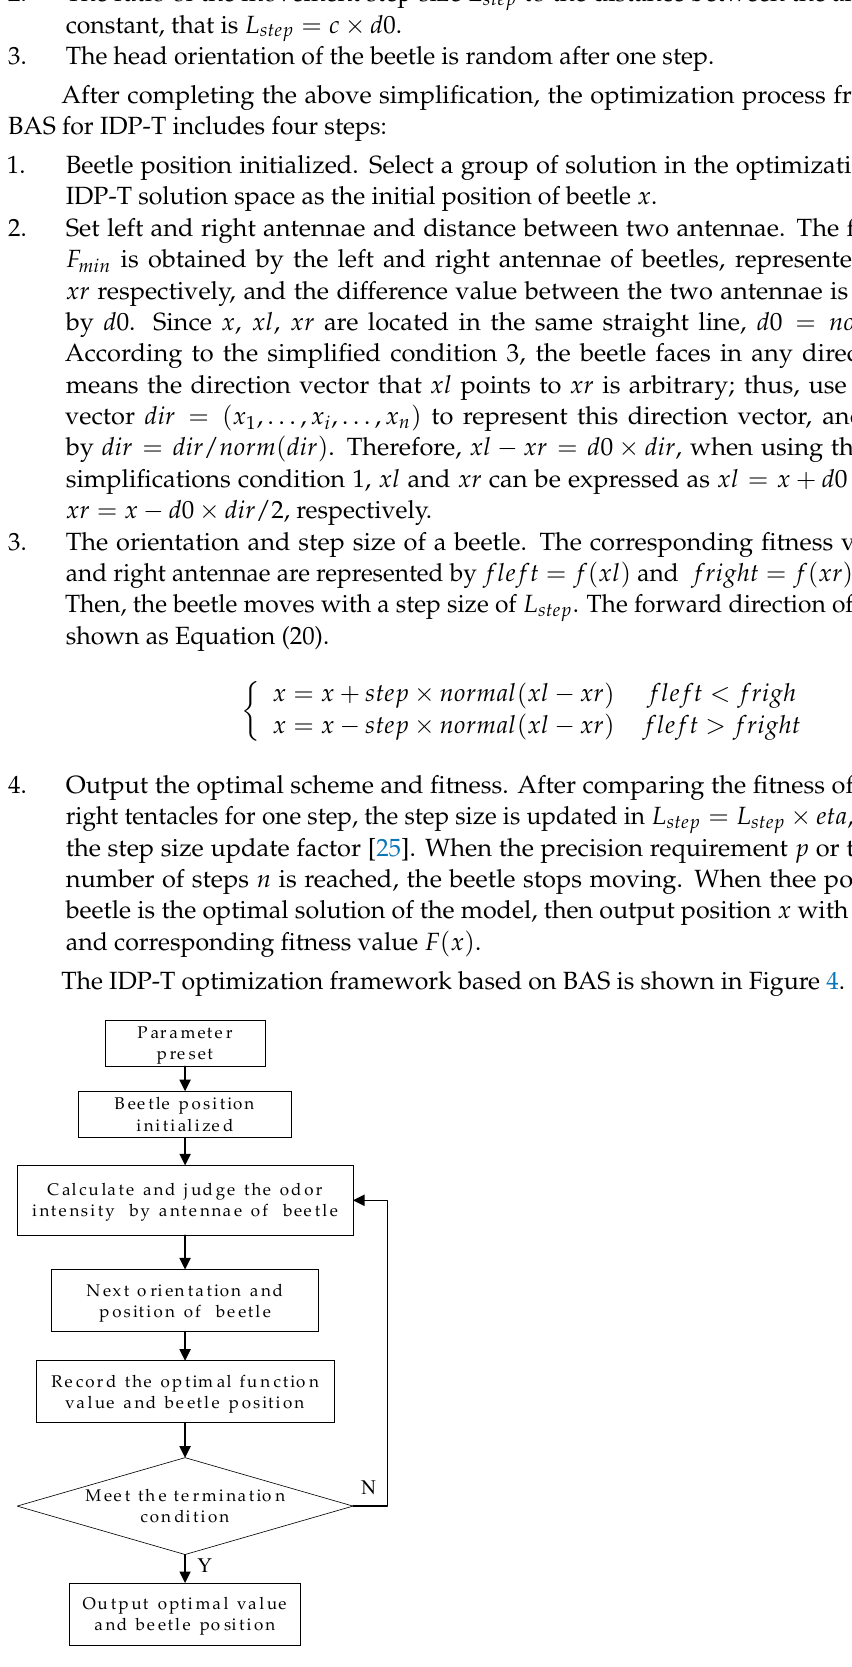
Figure 4. IDP-T optimization framework based on BAS.